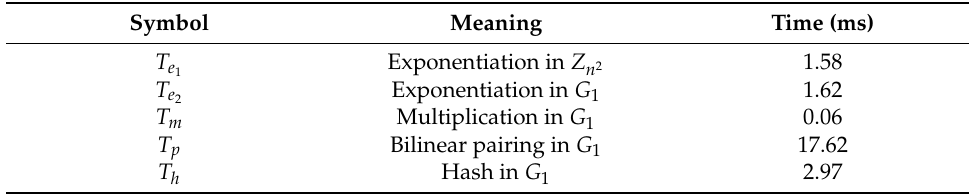
Table 2. Time costs of the